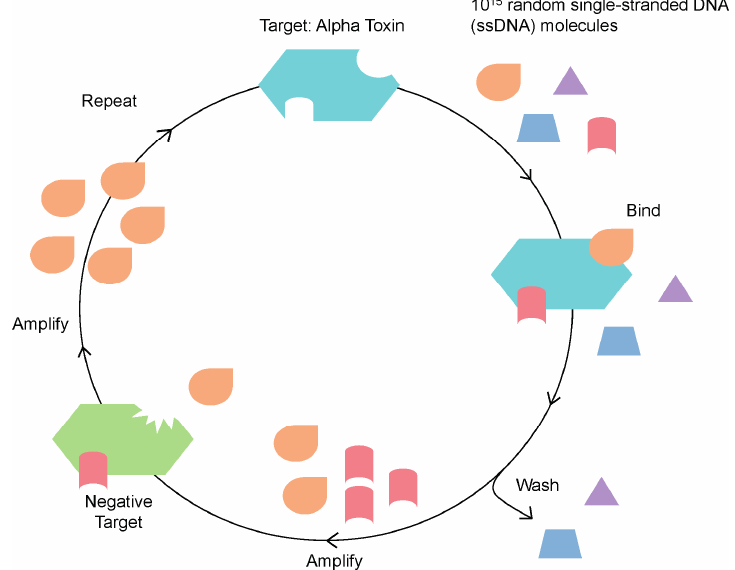
Figure 1. Illustration of the Systematic Evolution of Ligands by EXponential enrichment (SELEX) process. A random library consisting of 10 15 ssDNA molecules (each with a different nucleotide sequence, indicated by different shapes) were incubated with the target alpha toxin. Those DNA that bound to the target were amplified and then incubated with negative targets. Those DNA that do not bind to negative targets are amplified and subjected to further rounds of in vitro